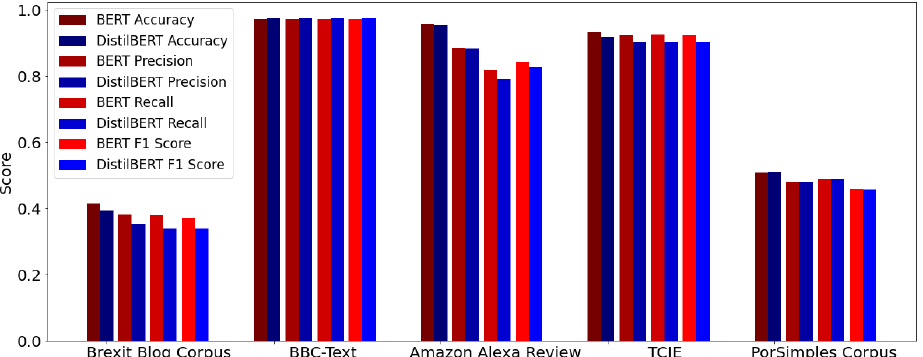
Figure 5. Bar plot comparing BERT and DistilBERT’s model